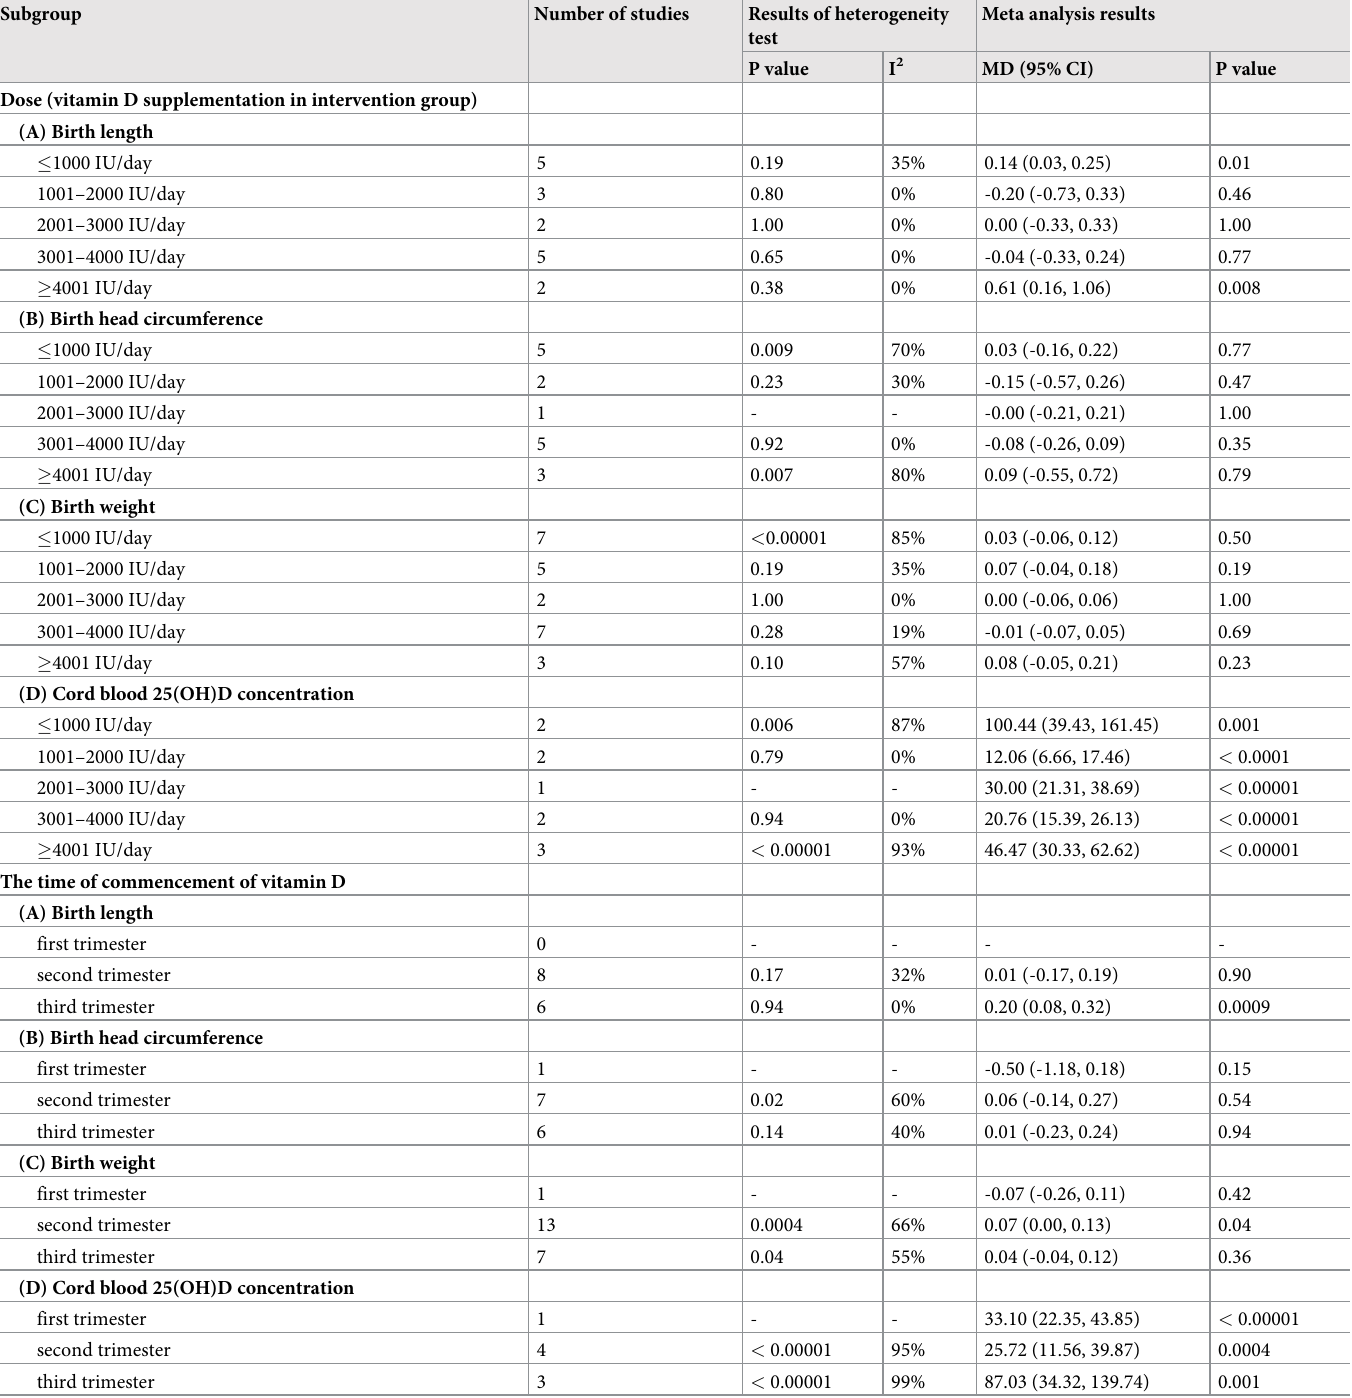
Table 2. Subgroup analysis